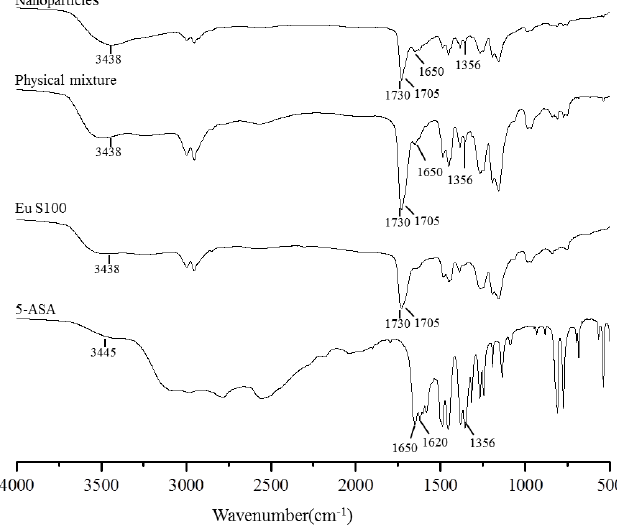
Figure 8. FTIR spectra of 5-ASA, EU S100, physical mixture and nanoparticles (12 MPa, 35 °C, 1.0 mg/mL, 1.0